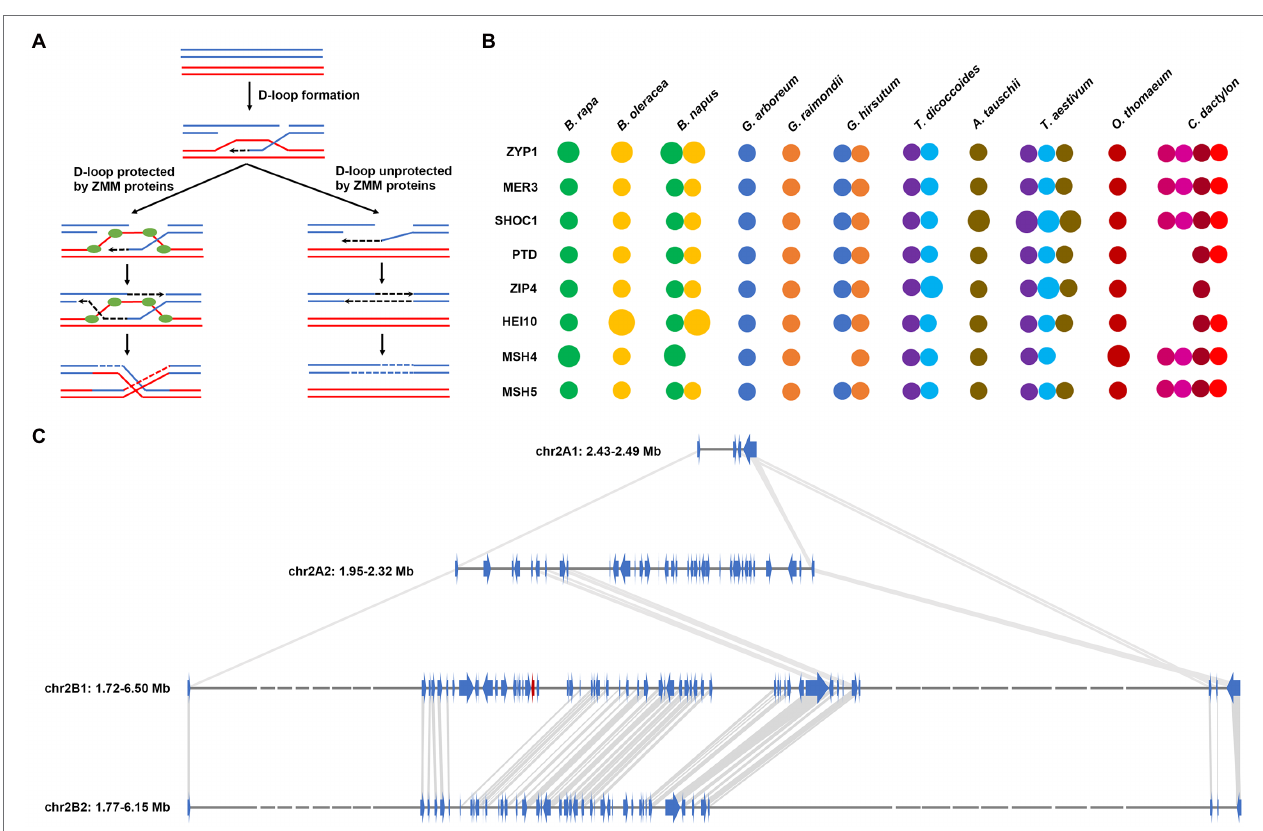
FIGURE 4 | Evolution of homologous recombination-regulating genes in C. dactylon. (A) Diagram depicting the essential roles of ZMM proteins in regulating homologous recombination. (B) Comparison of the gene copy number of eight ZMM proteins in C. dactylon , O. thomaeum , and other nine species with different ploidy levels. (C) Enlarged chromosomal gene location map showing the loss of ZIP4 gene and other contiguous genes in haplotype A1, A2, and B2 of C. dactylon . The ZIP4 gene in haplotype B1 was shown in red